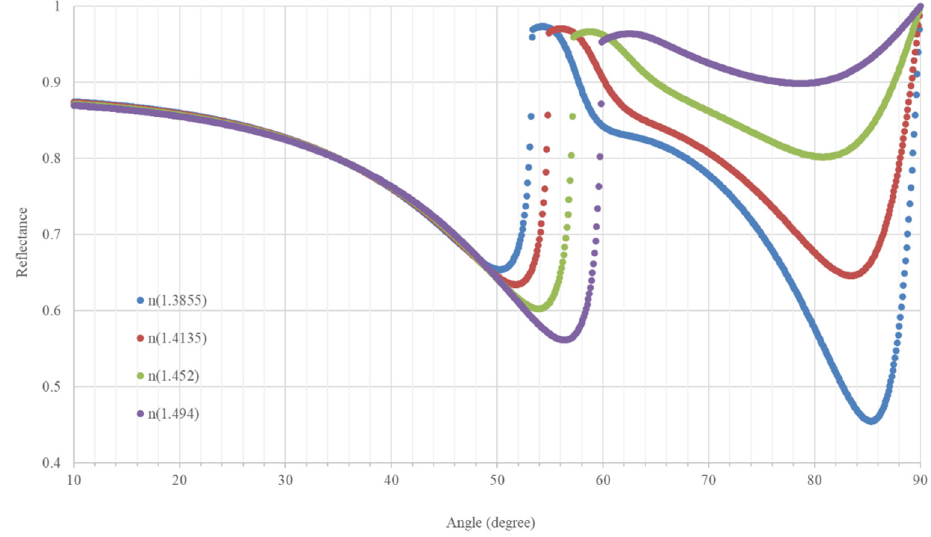
Figure 2. Reflectance curves as a function of the angle of incidence of the light in the prism for the range of refractive index values.